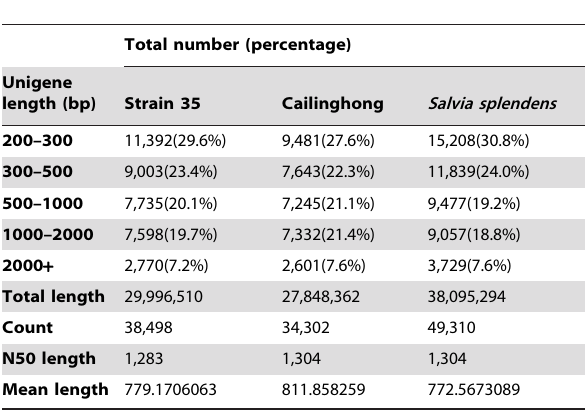
Table 4. Annotation of